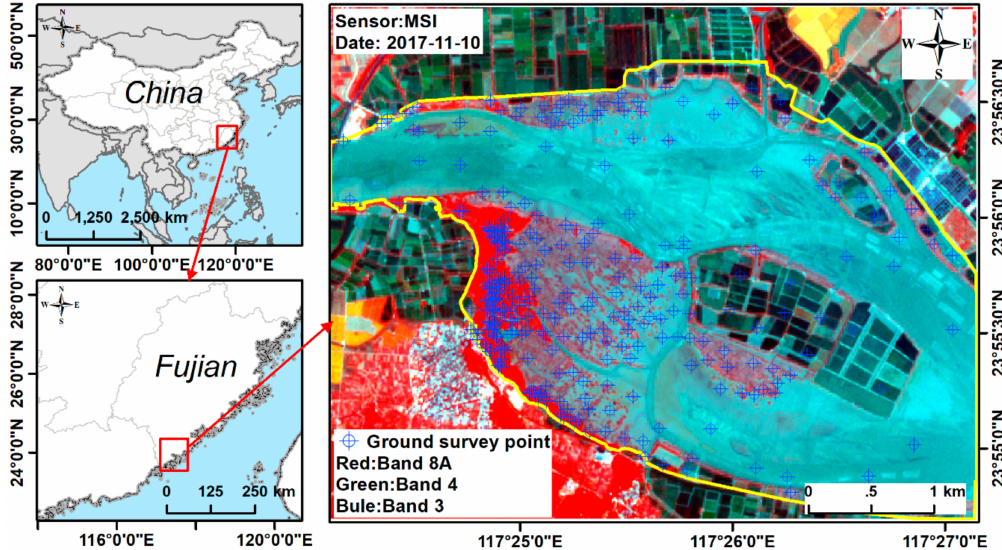
Figure 1. Location of study area and spatial distributions of ground survey